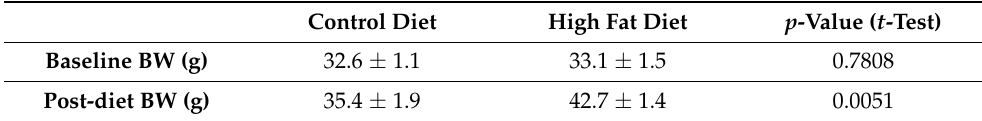
Table 1. Bodyweight measurements in CD-1 mice.